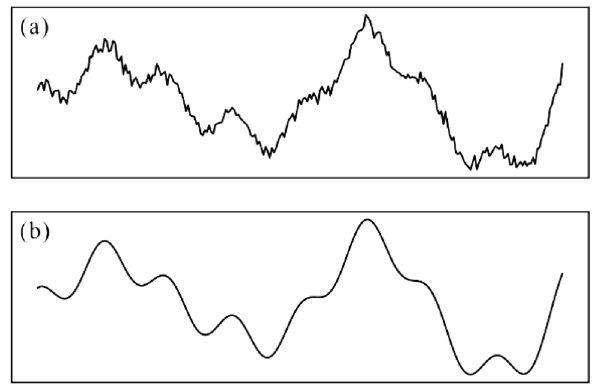
Figure 1. Denoising effect of wavelet analysis: ( a ) original signal; and ( b ) signal processed with wavelet